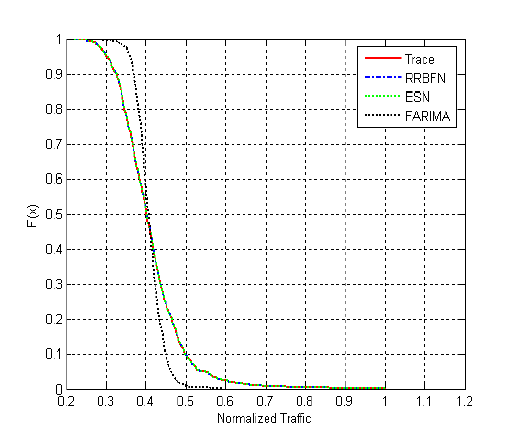
Fig. 7. 10-Step Traffic Prediction (1-Minute Interval)